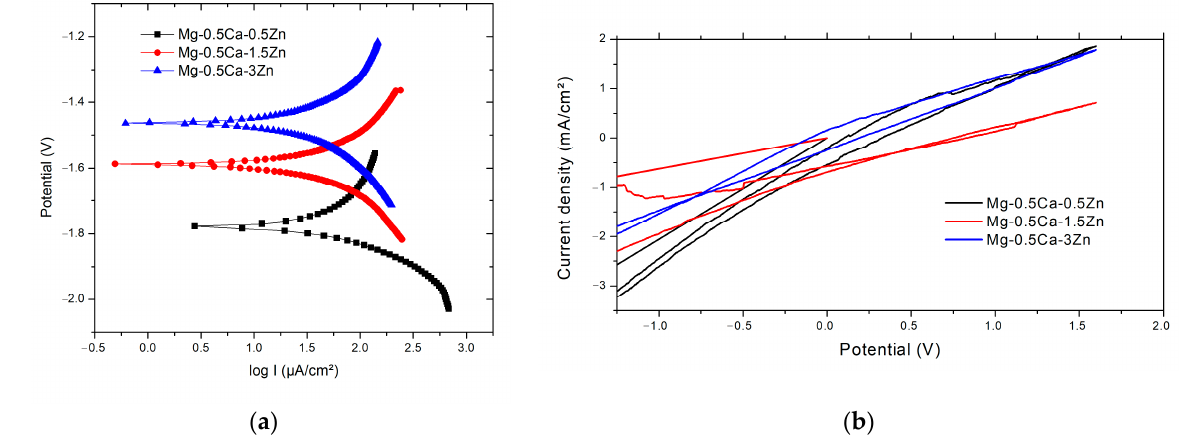
Figure 9. Electro-corrosion resistance test ( a ) Tafel representation and ( b ) cyclic curves.